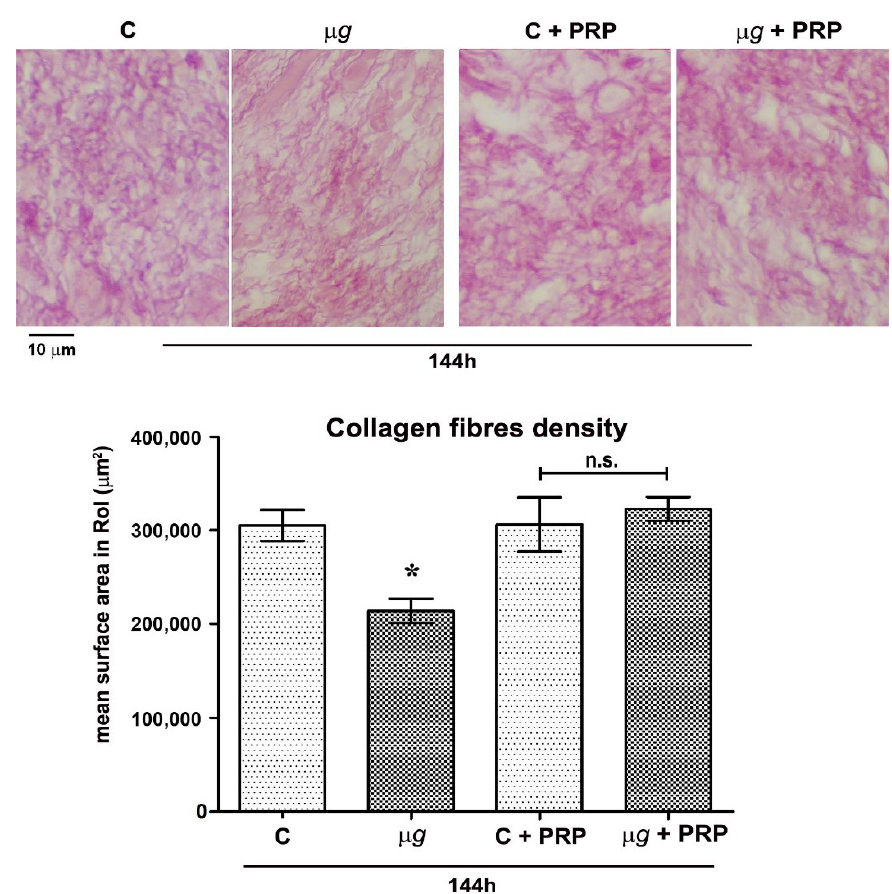
Figure 5. E ff ect of simulated µ g and PRP treatment on in vivo model of sutured wound healing ( Hirudo medicinalis ): Collagen fibre content after 144 h. Light microscopical analysis and morphometric quantitation of picrosirius red-stained collagen fibres in the connective tissue at the wound site in control and µ g -exposed animals, treated / untreated with PRP. C = 1 × g ; * p < 0.05 vs. all the other groups ( n = 3); n.s. = not significant. To note the significantly higher collagen fiber density in µ g -exposed animals treated with PRP compared with the untreated.